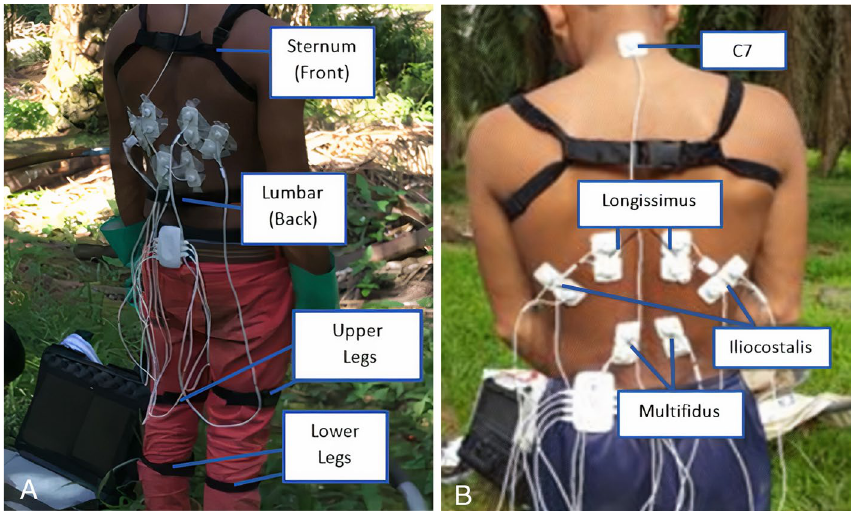
Figure 3. IMU Sensor placement ( A ) and EMG sensor placement ( B ) on Collector’s